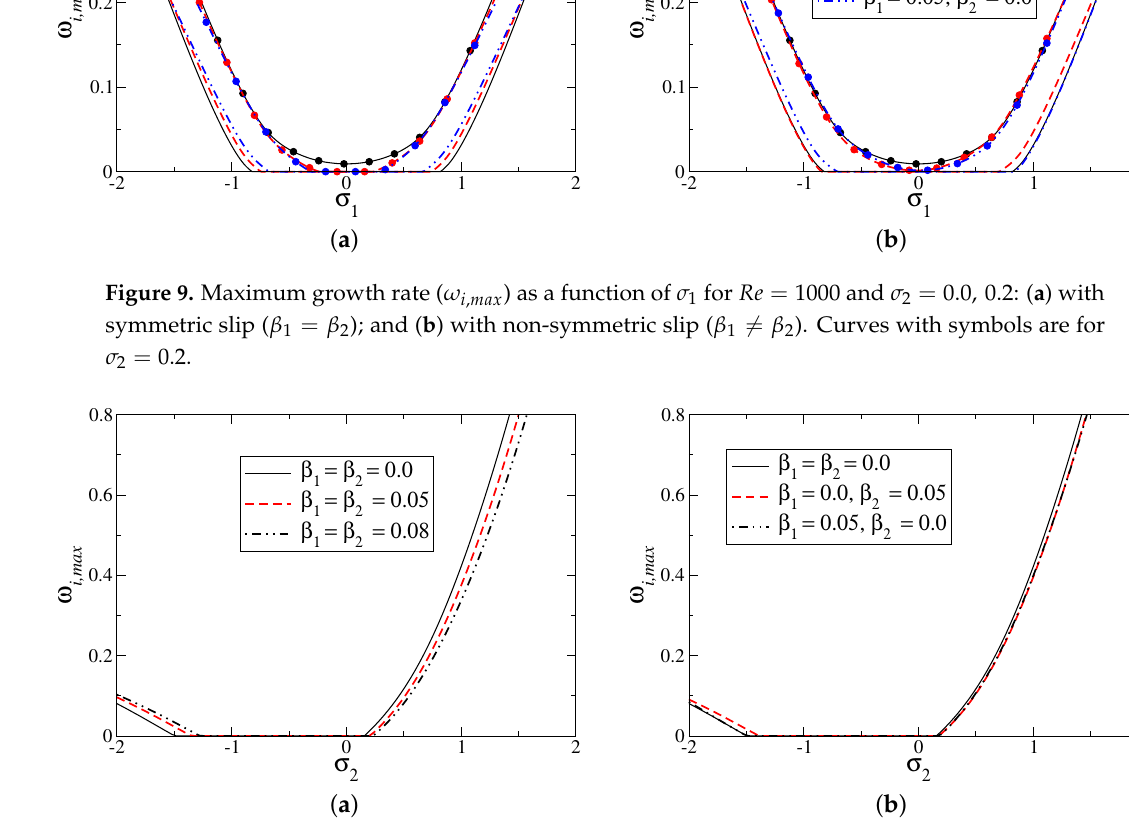
Figure 10. Maximum growth rate ( ω i , max ) as a function of σ 2 for Re = 1000, σ 1 = 0.0: ( a ) symmetric slip ( β 1 = β 2 ) and ( b ) non-symmetric slip ( β 1 (cid:54) = β 2